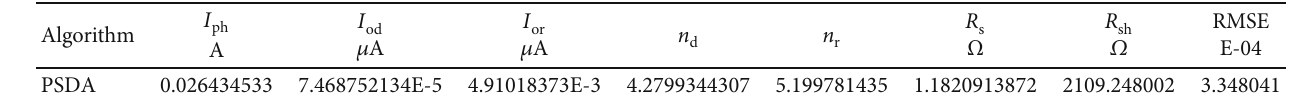
Figure 12: Comparison between the two-diode and one-diode model for LSM 20 panel. Table 5: The seven parameters of the STE 4/100 photovoltaic